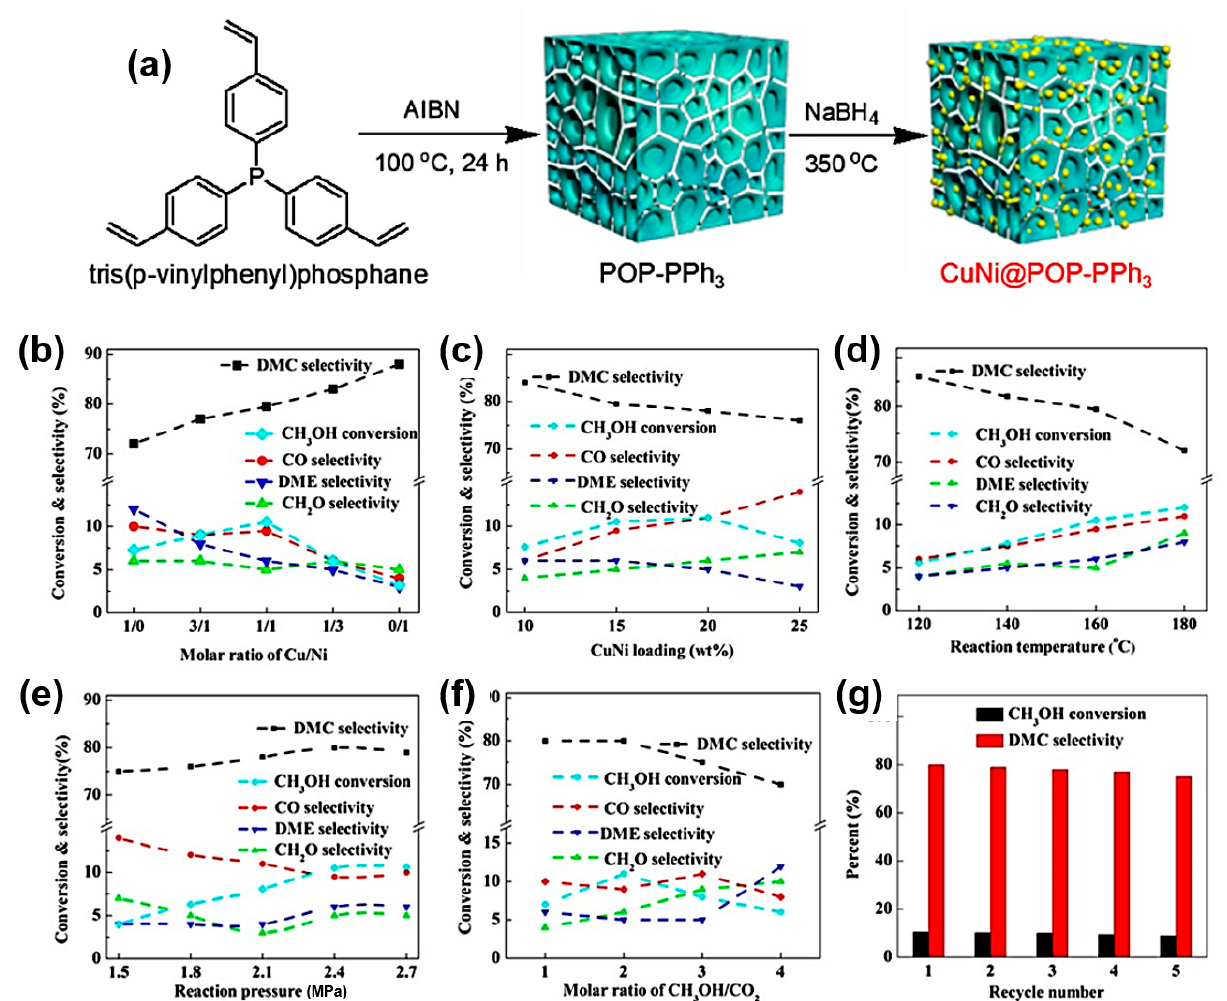
Figure 6. ( a ) Pathway of the synthesis of Cu x Ni y @POP-PPh 3 . Catalytic performance of the Cu x Ni y @POP-PPh 3 as a function of ( b ) Cu/Ni ratio, ( c ) metal loading, ( d ) temperature, ( e ) pressure,